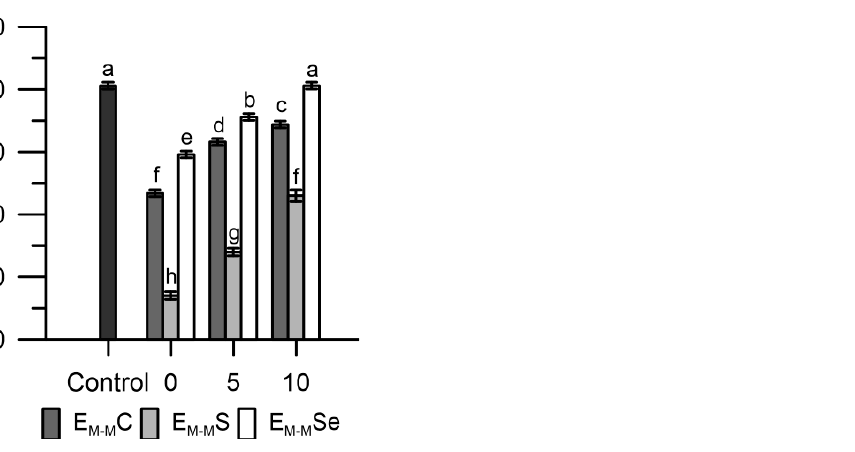
Figure 6. Germination of maize pollen grains in the presence of wheatgrass extracts (50 μ g) obtained from grains sprouted with distilled water as a control (E M-M C) or in the presence of salinity (NaCl 50 mM) (E M-M S) or selenium (Na 2 SeO 3 45 mg L − 1 ) (E M-M Se). The pollen was pre-treated or not in vitro with 5 and 10 μ M Na-selenate (SeO 42 − ). Data are expressed as means ± SEM from five independent tests. Different letters above bars indicate significant differences at p ≤ 0.05, whereas same letters indicate non-significant differences.